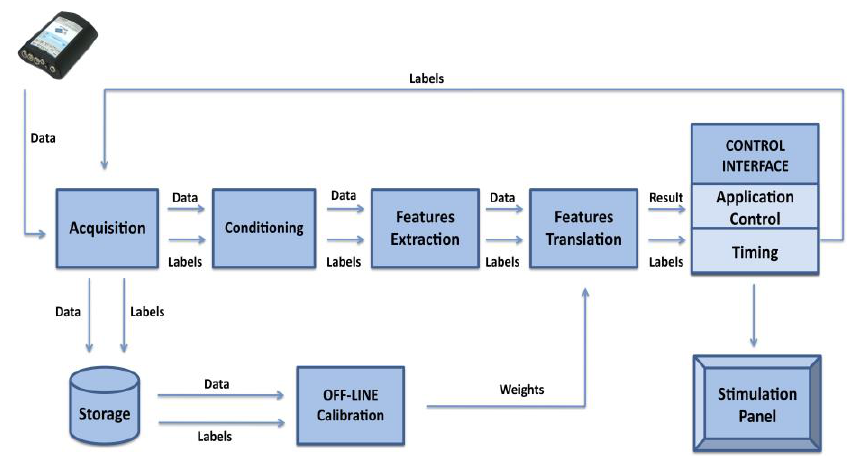
Figure 4. Block diagram of the FPGA-based system.